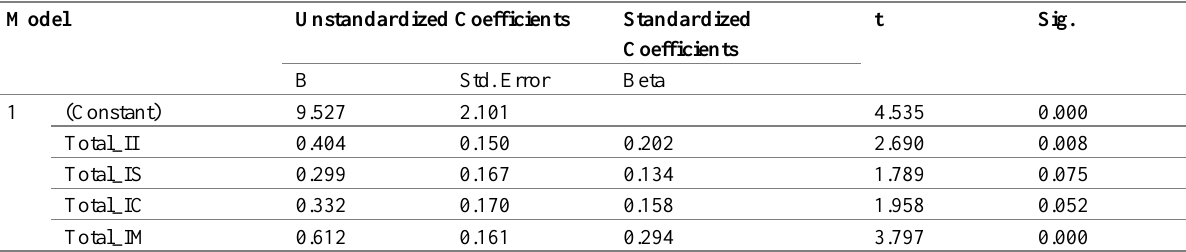
Table 1: Multiple Regression